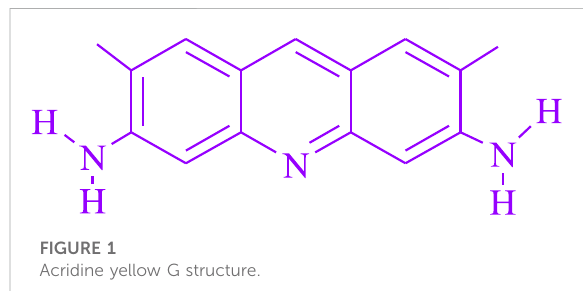
FIGURE 1 Acridine yellow G